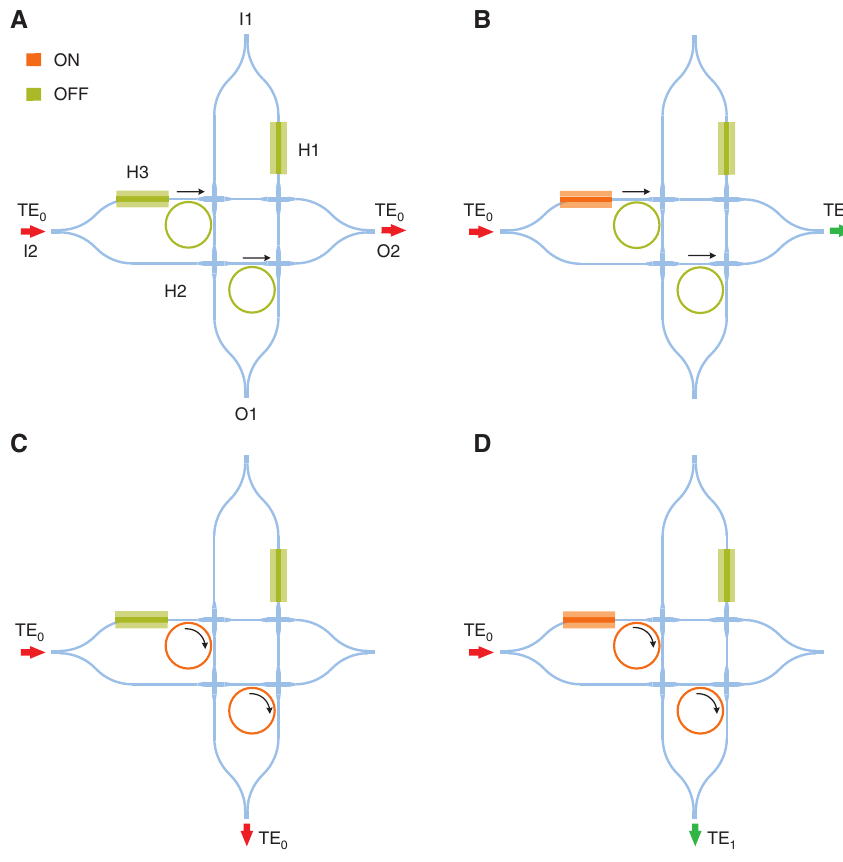
mode launched into port I2 for four switching configurations. 0